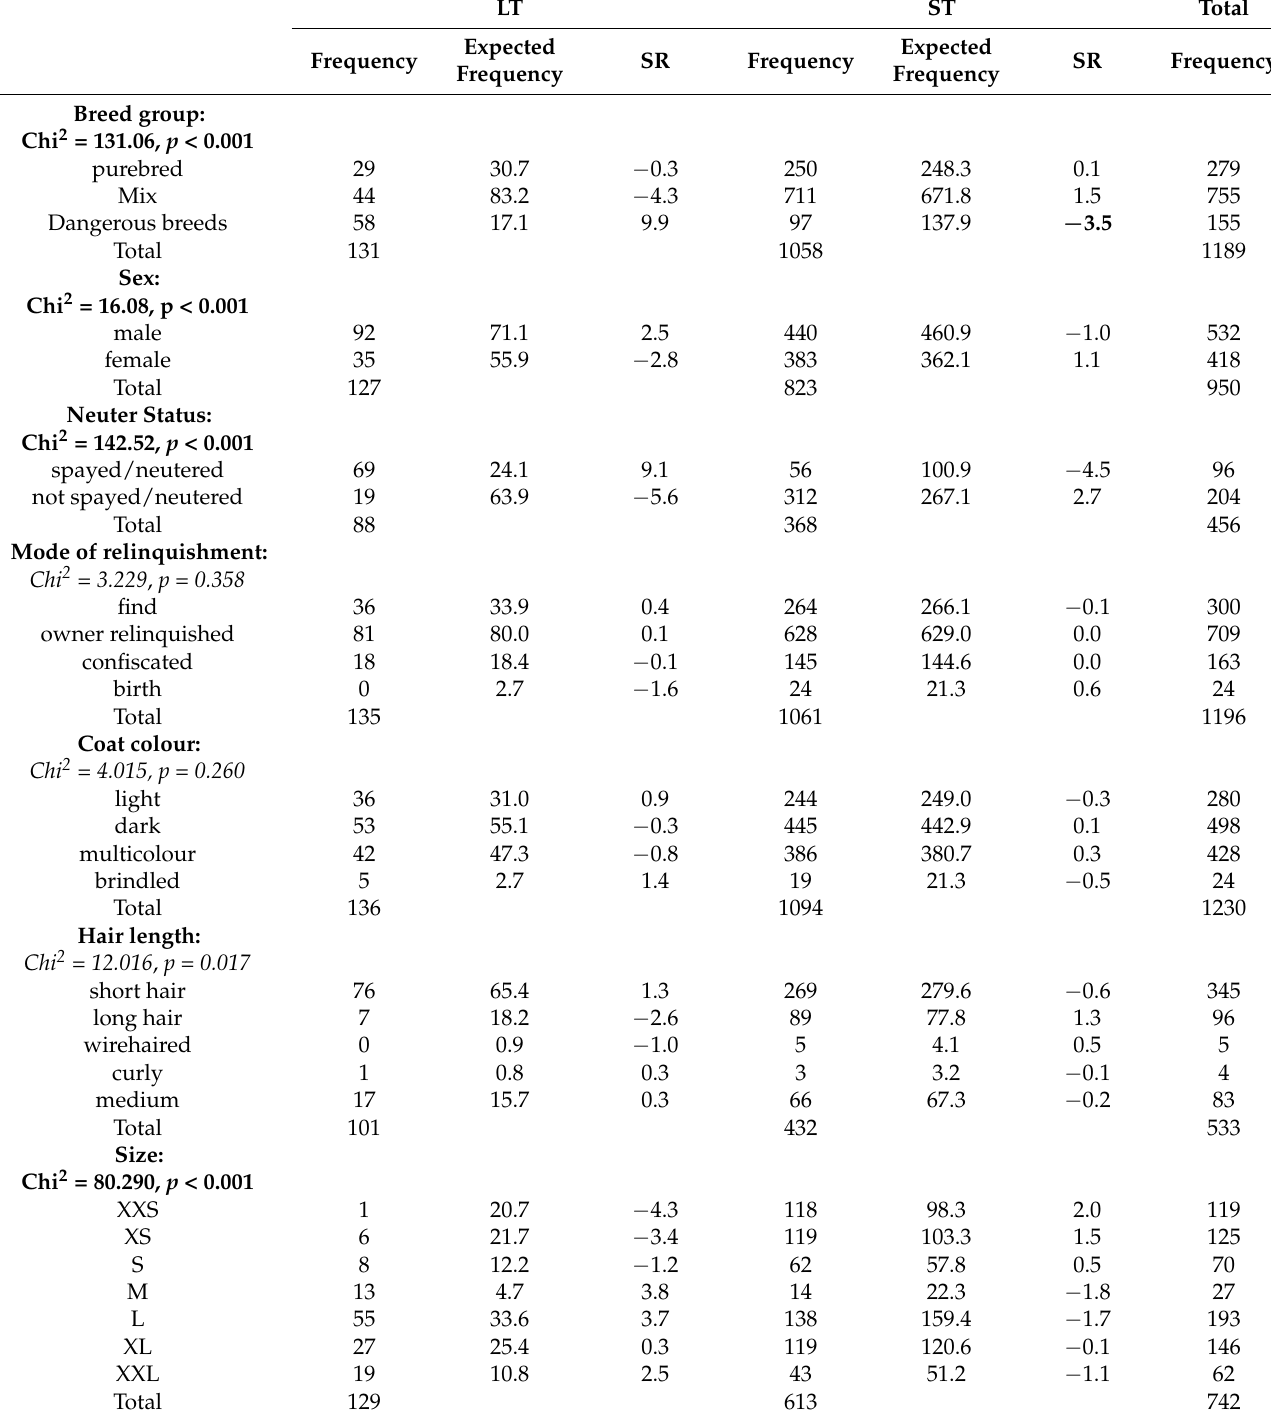
Table 2. Crosstab of the general and morphological characteristics of short-term shelter dogs (ST) and long-term shelter dogs (LT) groups. The ST group only included already rehomed dogs with a maximum length of stay of five months. Due to correction for multiple testing with Bonferroni correction for 15 tests, Chi 2 tests are considered significant with p ≤ 0.003 and as a trend with 0.003 < p ≤ 0.006. Significant results are shown in bold and trends in italics. Standardised residuals (SR) greater or smaller than 2 or − 2 are marked with bold numbers. For these characteristics, the observed frequency deviates from the expected